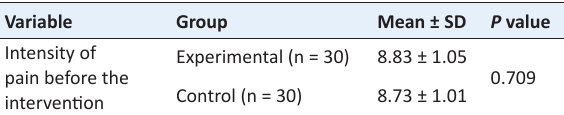
Table 1. Comparison of the mean intensity of pain of leg muscle cramp before the intervention in the experimental and control groups